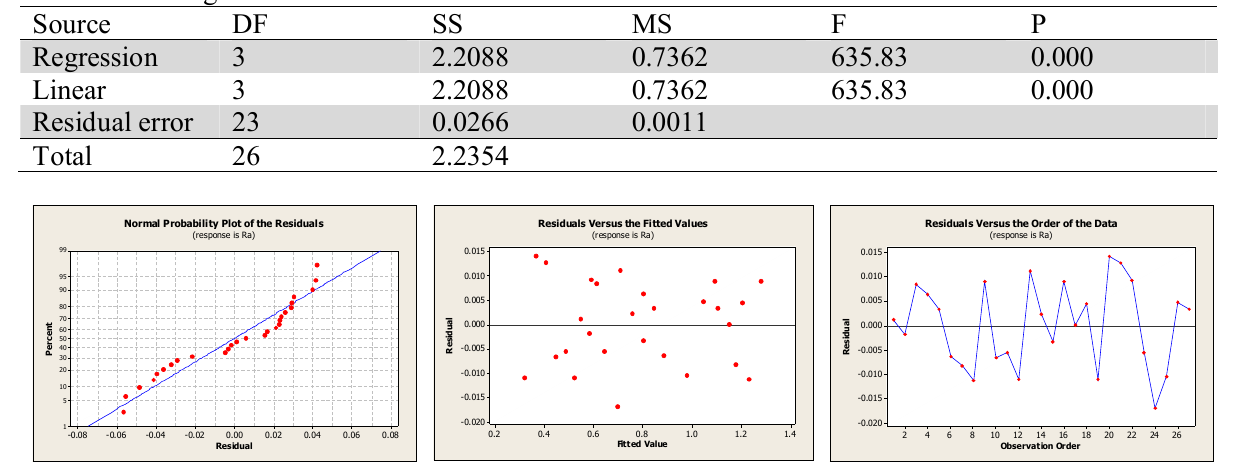
Fig. 8. Normal probability plot Fig. 9. Residuals vs. the fitted Fig. 10. Residuals vs. the order